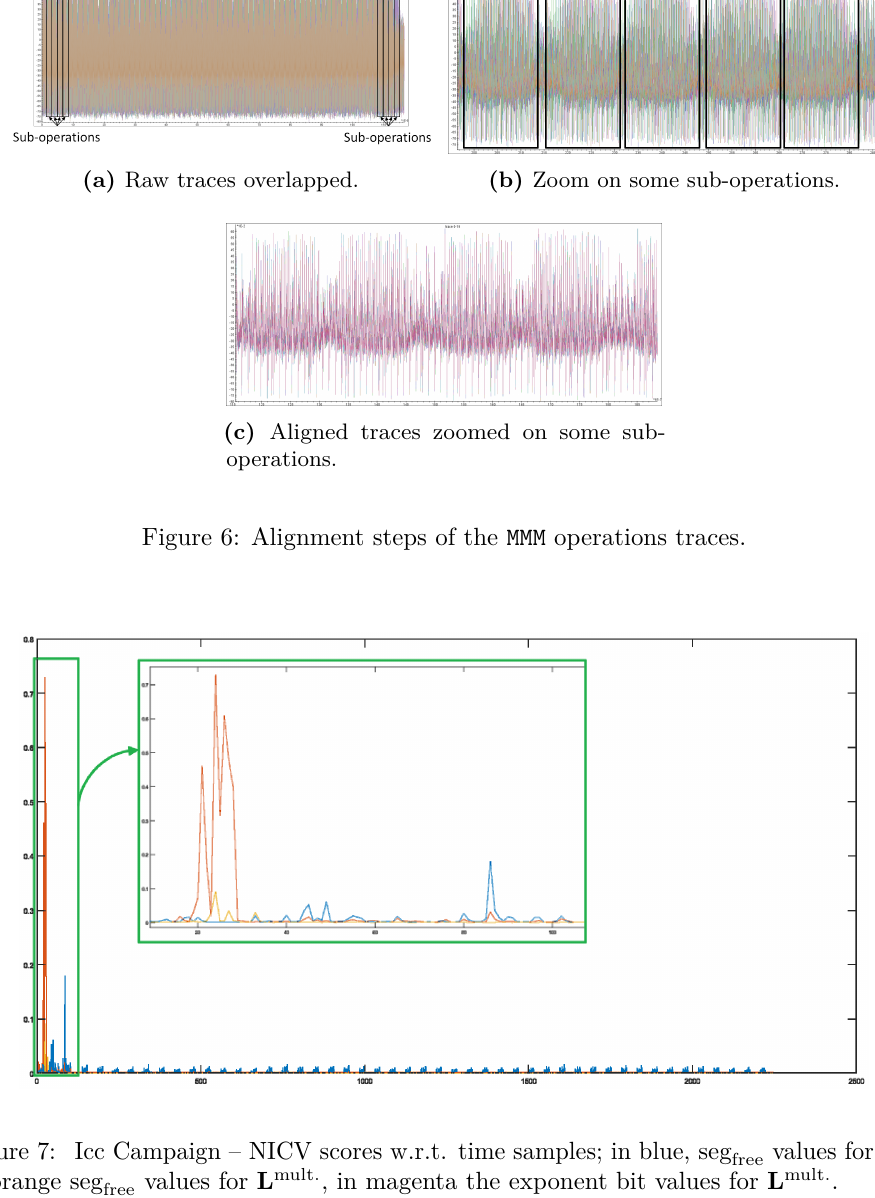
Figure 7: Icc Campaign – NICV scores w.r.t. time samples; in blue, seg